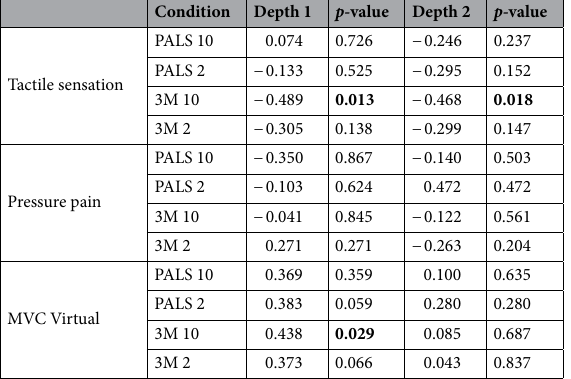
Table 3. Association between depth of median nerve and effect on different test outcomes. Testing for a significant association is done with the Spearman Rank test. Results are given as correlation coefficients. Significant p -values are in